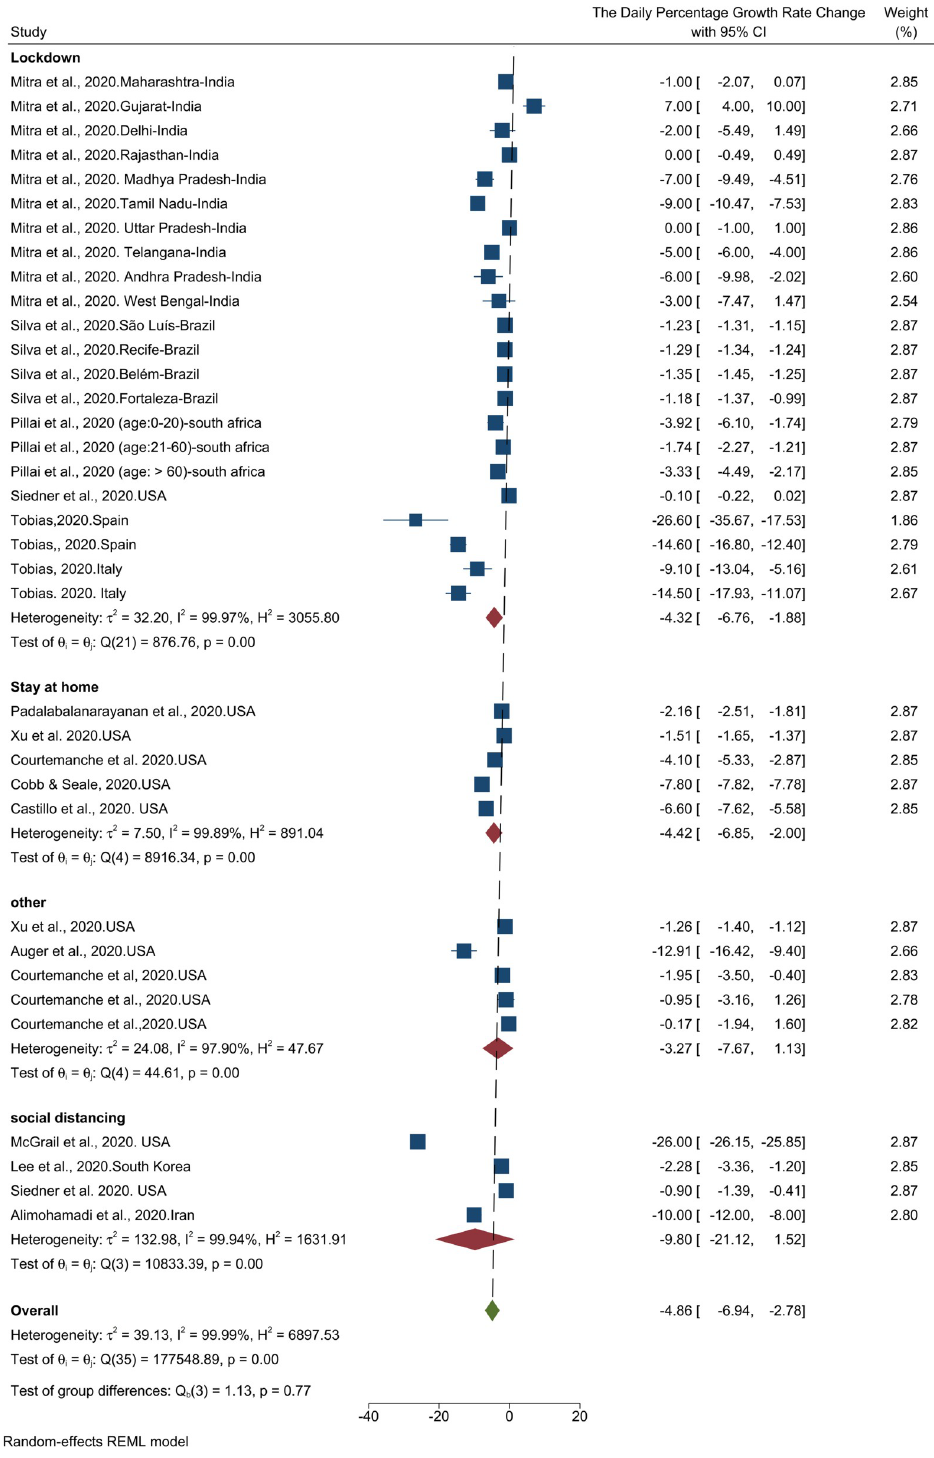
PLOS ONE | https://doi.org/10.1371/journal.pone.0260371 November23,